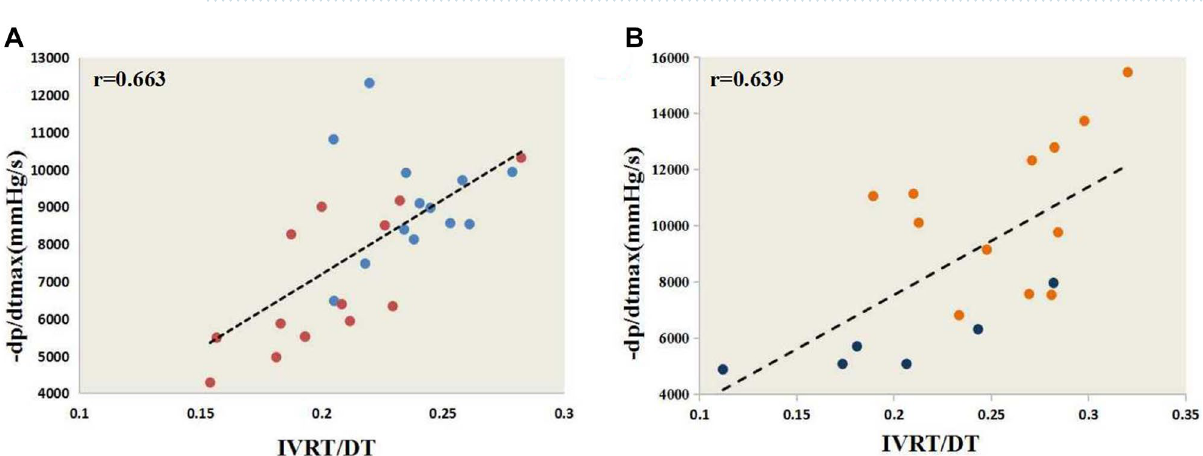
Figure 4. The correlation of IVRT/DT with − dP/dtmax. ( A ) IVRT/DT and − dp/dtmax correlation analyses in males by Spearman’s rank correlation test. ( B ) IVRT/DT and − dp/dtmax correlation analyses in females by Spearman’s rank correlation. * − dp / dtmax the maximum drop rate of pressure in left ventricle; IVRT/DT isovolumetric relaxation time/ diastolic time interval.